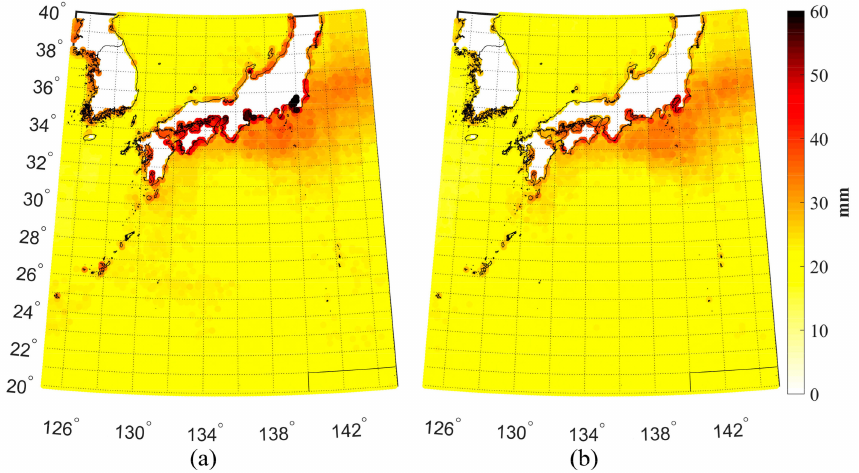
Figure 6. The error distribution of ( a ) DTU15 MSS; ( b ) DTU18